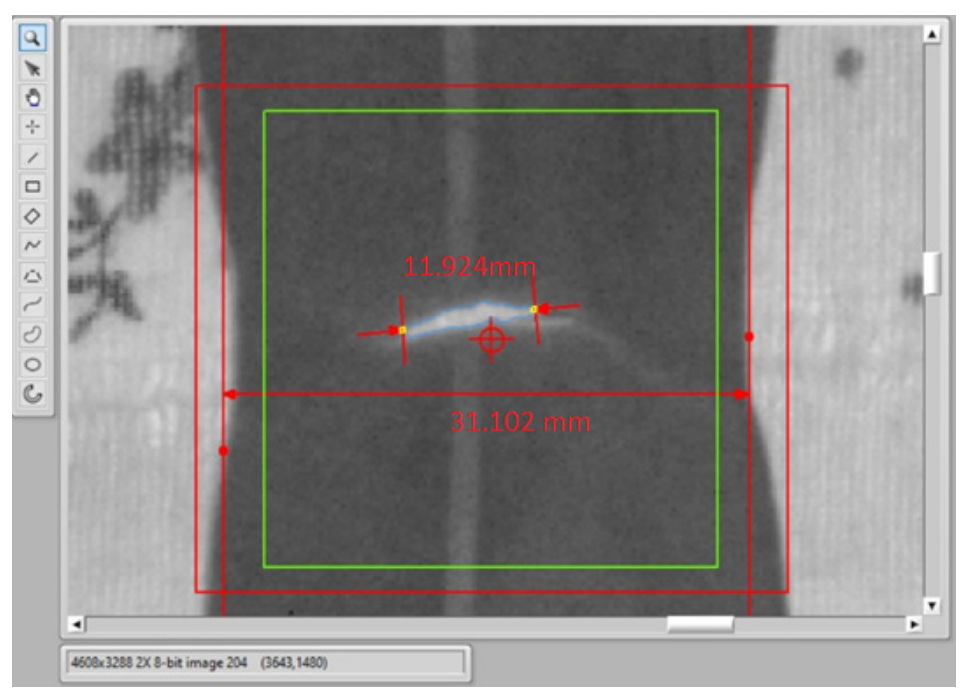
Figure 11. Detail of the detected crack and measurement of its properties.